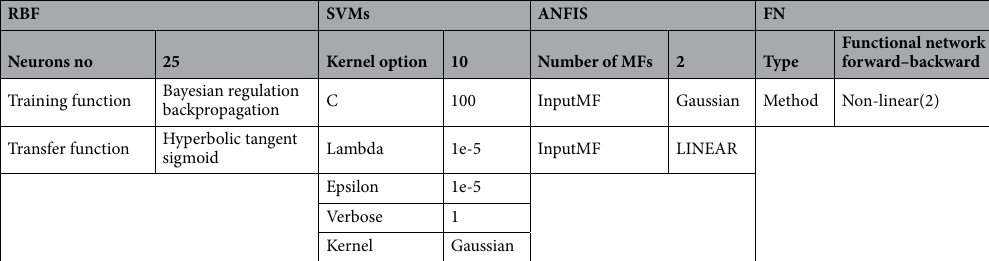
Table 2. Sensitivity analysis results for the optimized ML models’